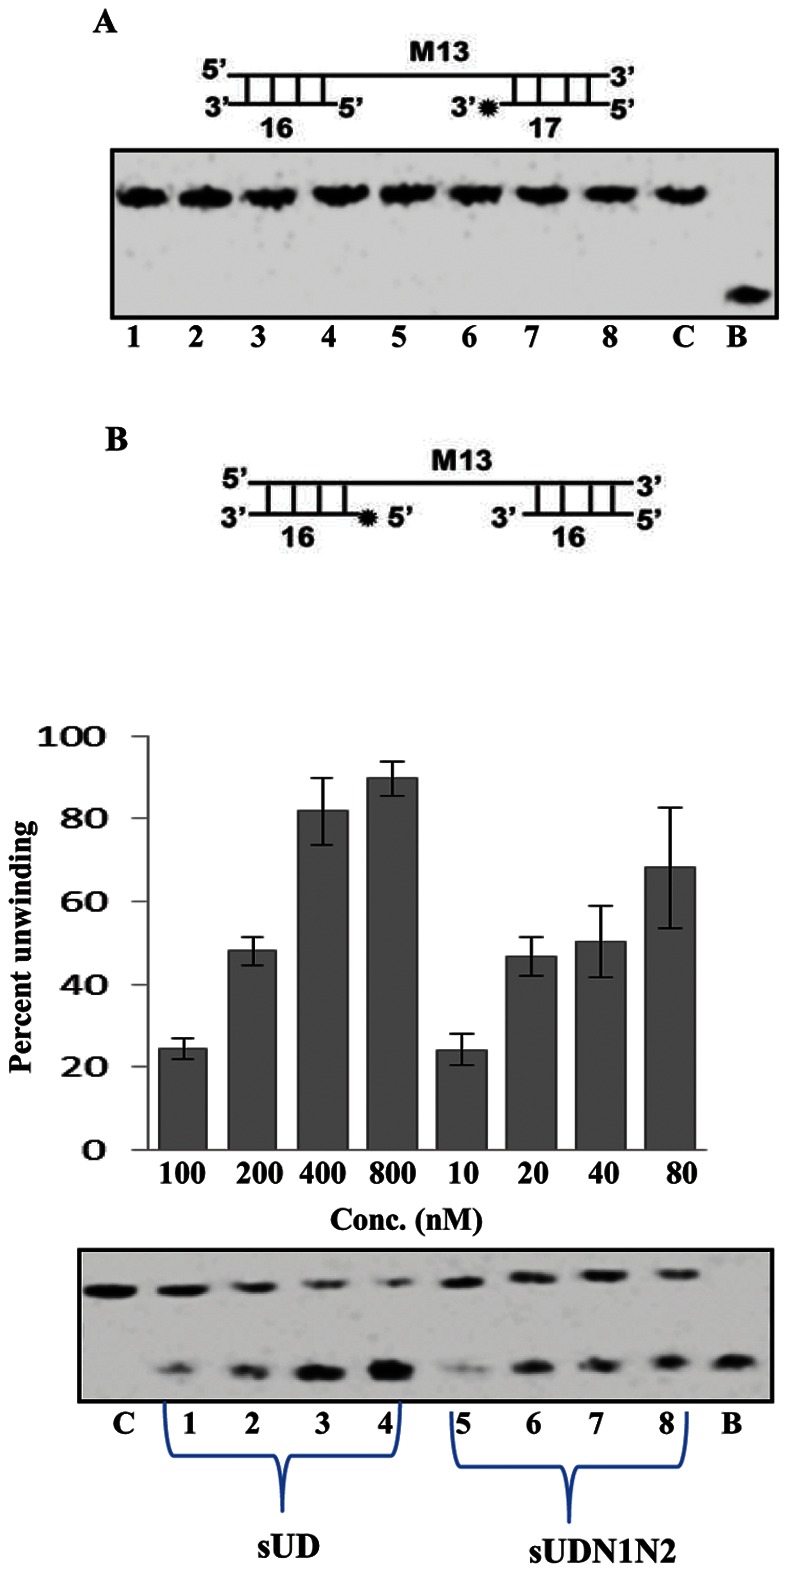
Representation of direction specific unwinding activity.A. 5′ to 3′ direction specific substrate. Lanes 1–4, increasing concentration of sUD, lanes 5–8, increasing concentration of sUDN1N2. B. 3′ to 5′ direction specific substrate. Lanes 1–4 contain increasing concentration of sUD, lanes 5–8, increasing concentration of sUDN1N2. In panel A and B, the structure of the substrate is shown and asterisk (*) denotes the 32P-labeled end and lane C is reaction without protein and lane B is heat denatured substrate. Quantitative data of figure B are shown and the concentration used is written on X axis of bar diagram.